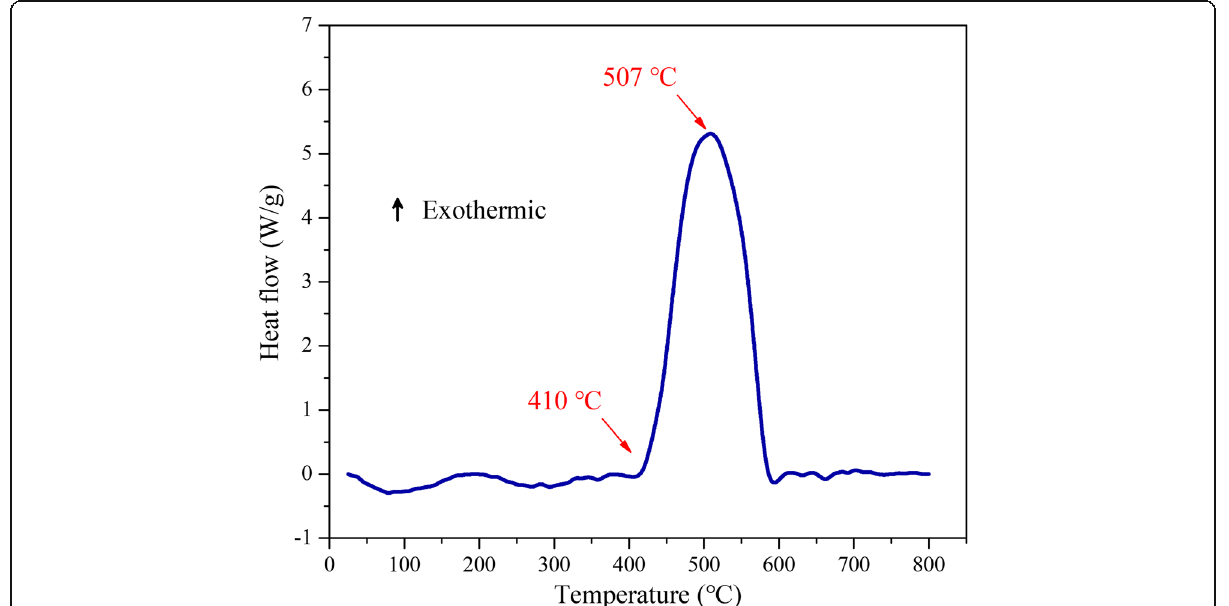
Fig. 4 DSC curves of the Al/PTFE nanolaminates as a function of temperature in argon environment